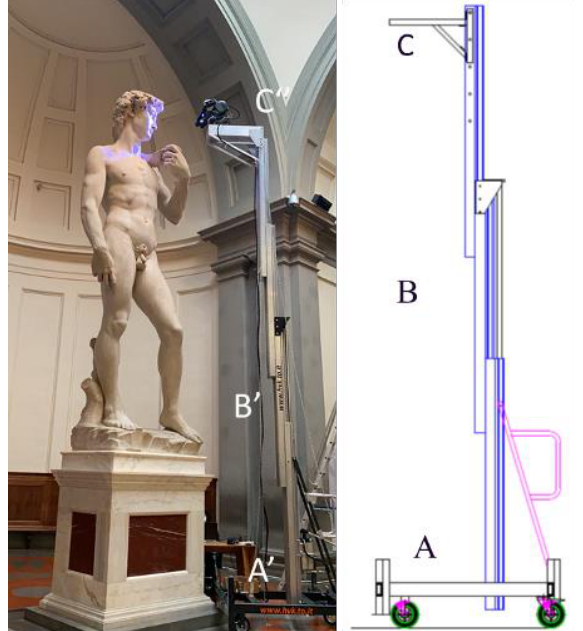
Figure 1: Surveying of David at the Galleria dell’Accademia museum in Florence: on the left, the ad-hoc gantry, made and optimized by 2HVK sr. for scanning operations performed in 2020. On the right, the ad-hoc grant scheme (A-A’) platform, grant main structure (B-B’) scan’s support (C-C’)